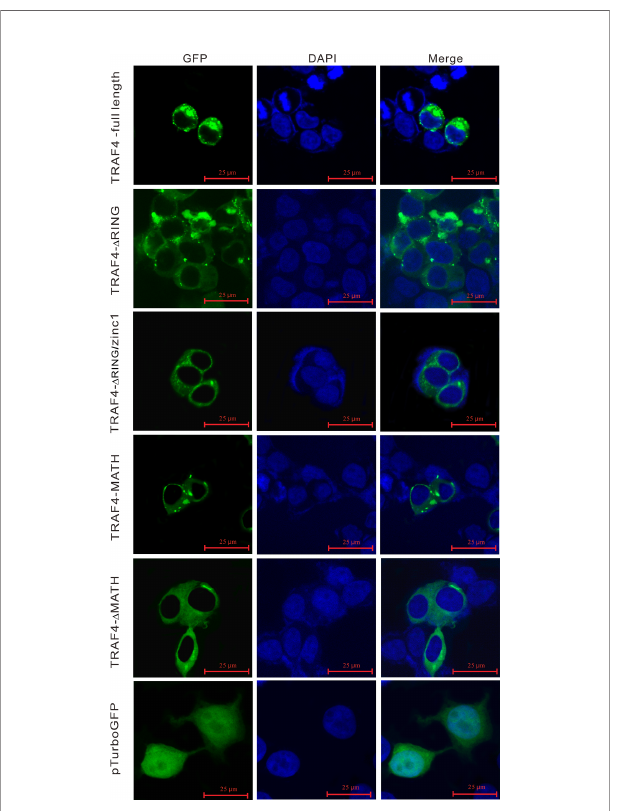
FIGURE 6 | Subcellular localization of Lc -TRAF4 and its truncated forms. HEK 293T cells were transfected with pTurbo-TRAF4-GFP, pTurbo-TRAF4- D RING-GFP, pTurbo-TRAF4- D RING/zinc1-GFP, pTurbo-TRAF4-MATH-GFP, pTurbo-TRAF4- D MATH-GFP, and pTurboGFP-N (vector control), respectively. At 24 hpt, cells were stained with DAPI, detected and photographed under a confocal microscope.